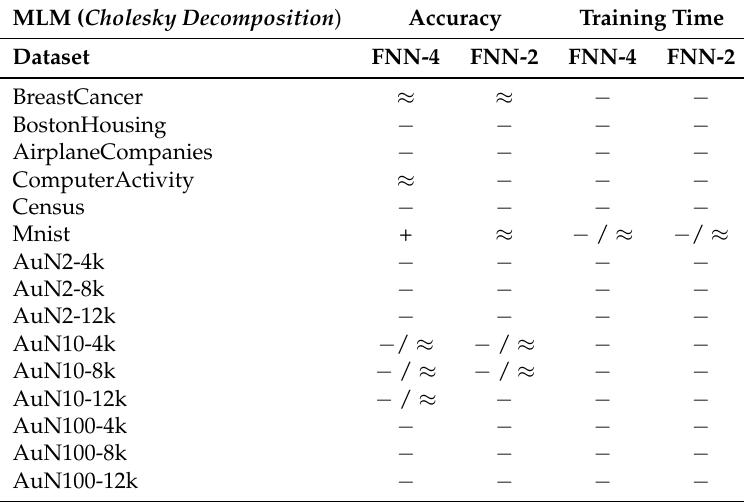
Table 5. Summary of comparison of MLM with Cholesky decomposition to a shallow (FNN-2) and a deep (FNN-4) neural network results. Symbols + , ≈ , and − indicate that the FNN results are better, no different, or worse than the MLM results, respectively. Symbol / and the symbols with it are used to signify that the FNN results are not properly in either